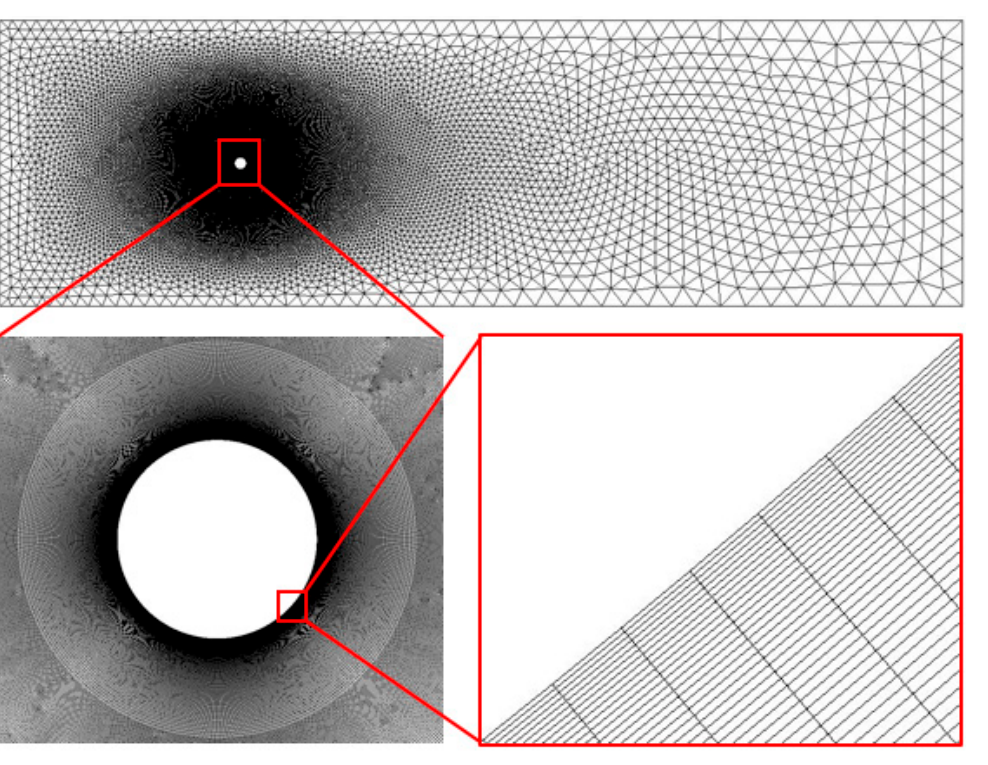
Figure 4. Mesh in the computational domain